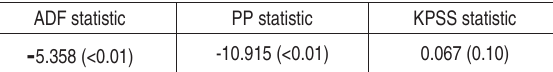
Table 3. Stationarity tests statistics for